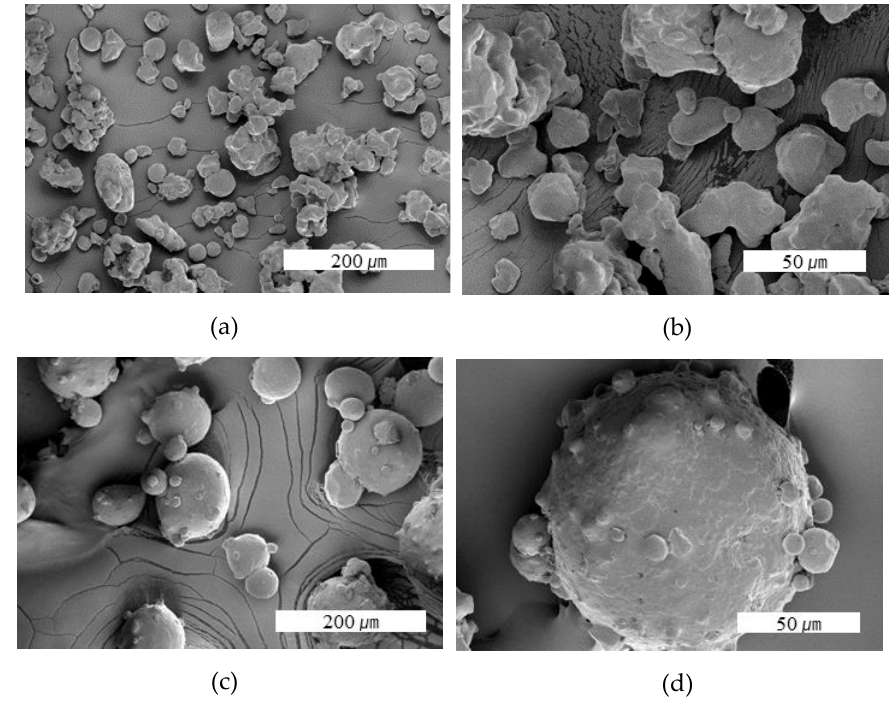
Figure 2. FE-SEM images for powder morphology. ( a ) Fe powder at low magnification, ( b ) Fe powder at high magnification, ( c ) STS316 at low magnification, and ( d ) STS316 at high magnification.